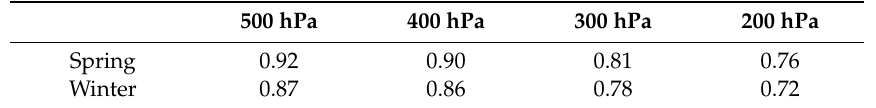
Table 1. Correlation coe ffi cients between the time sequences of 10-m wind speed and upper-level wind speed in spring and winter during